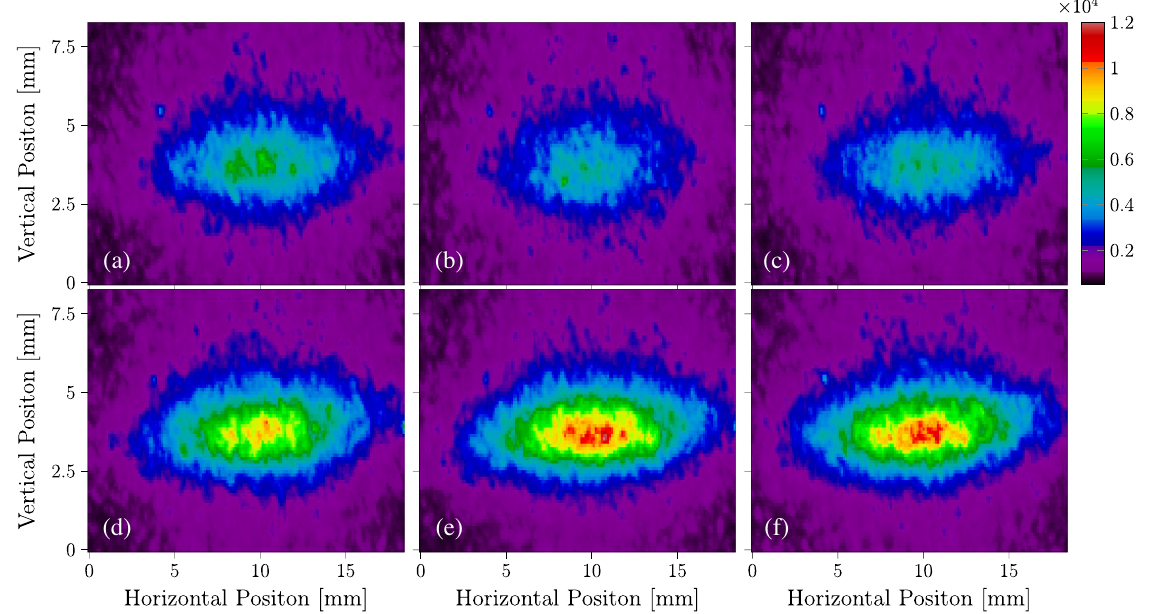
FIG. 10. Image with a steel (V2A) target at 20° with respect to normal at the polarization angle of (a) 0°, (b) 30°, (c) 60°, (d) 90°, (e) 120°, and (f)